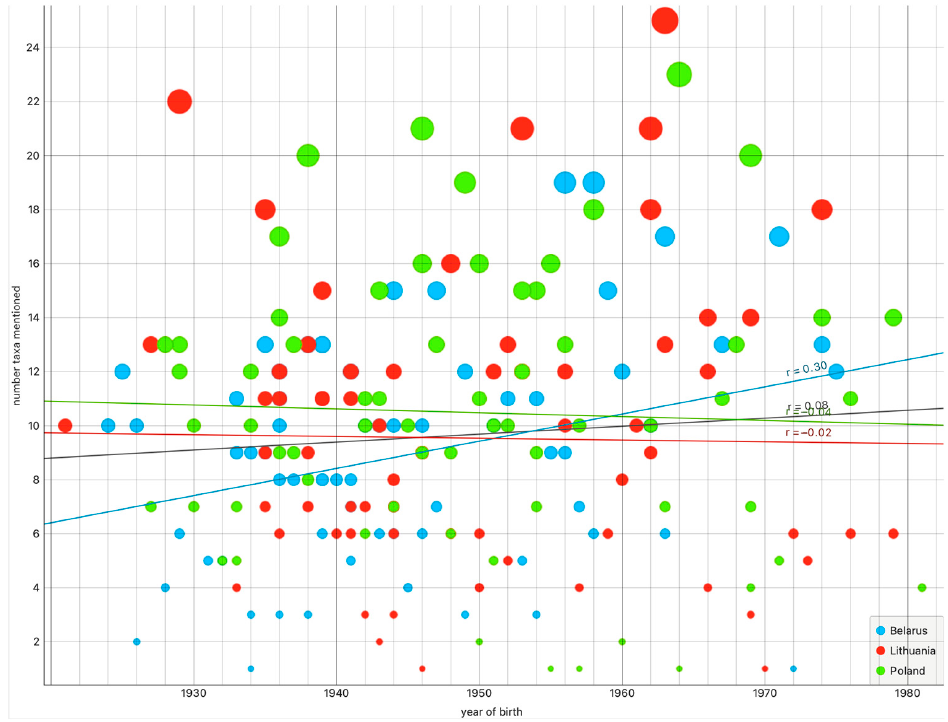
Figure 6. Distribution of the number of taxa mentioned in Belarus, Lithuania, and Poland according to the year of birth of interviewees. The size of the circle correlates with the number of taxa mentioned.